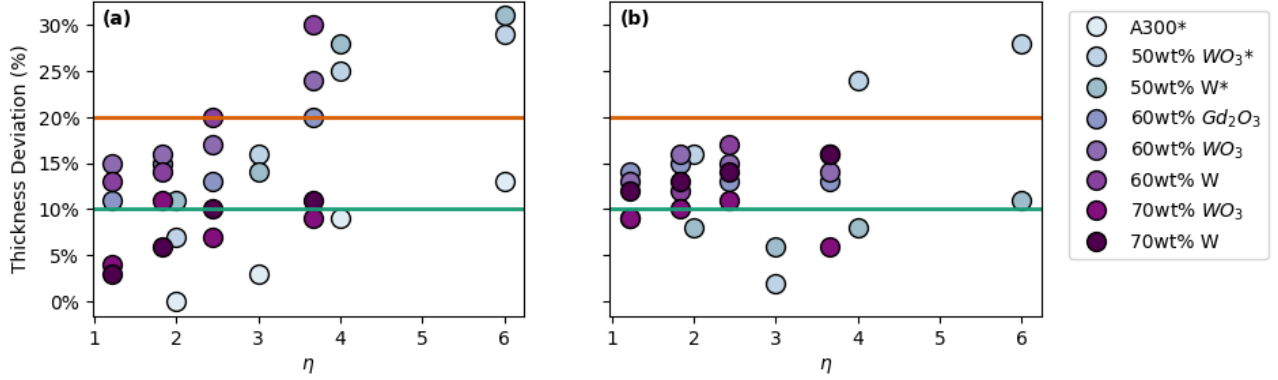
Figure 6. Side view microscope images of 60 wt% Gd 2 O 3 FCT prints using: ( a ) a 250 µm nozzle with 500 µm center-to-center strut distance ( η = 2) and ( b ) a 410 µm nozzle with 750 µm center-to-center strut distance ( η = 1.829).